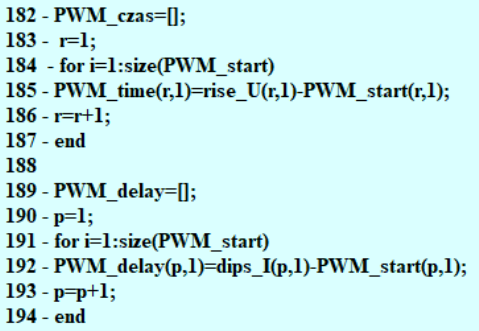
Figure 6. Assigning the time-ranges spotted by the algorithm. Figure 7. Finding the local minimum of the current intensity. Figure 7. Finding the local minimum of the current intensity.